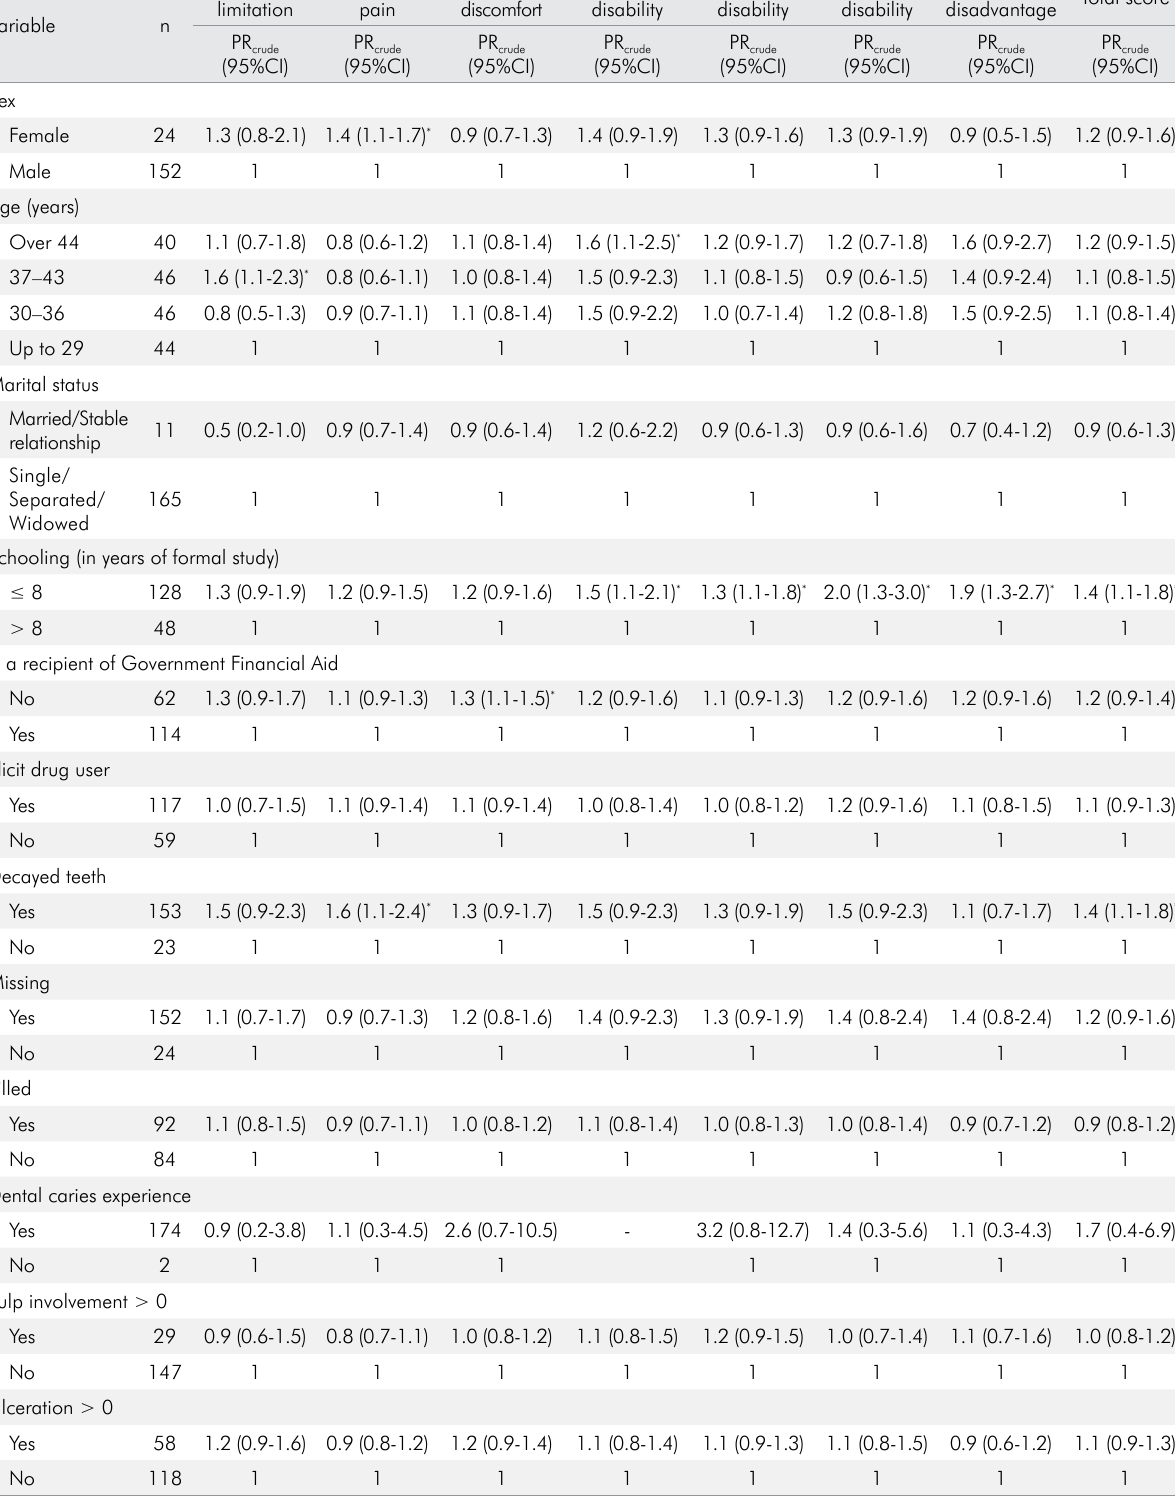
Table 2. Bivariate analysis between domains and total score of the OHIP-14 instrument with sociodemographic and oral health variables (n =